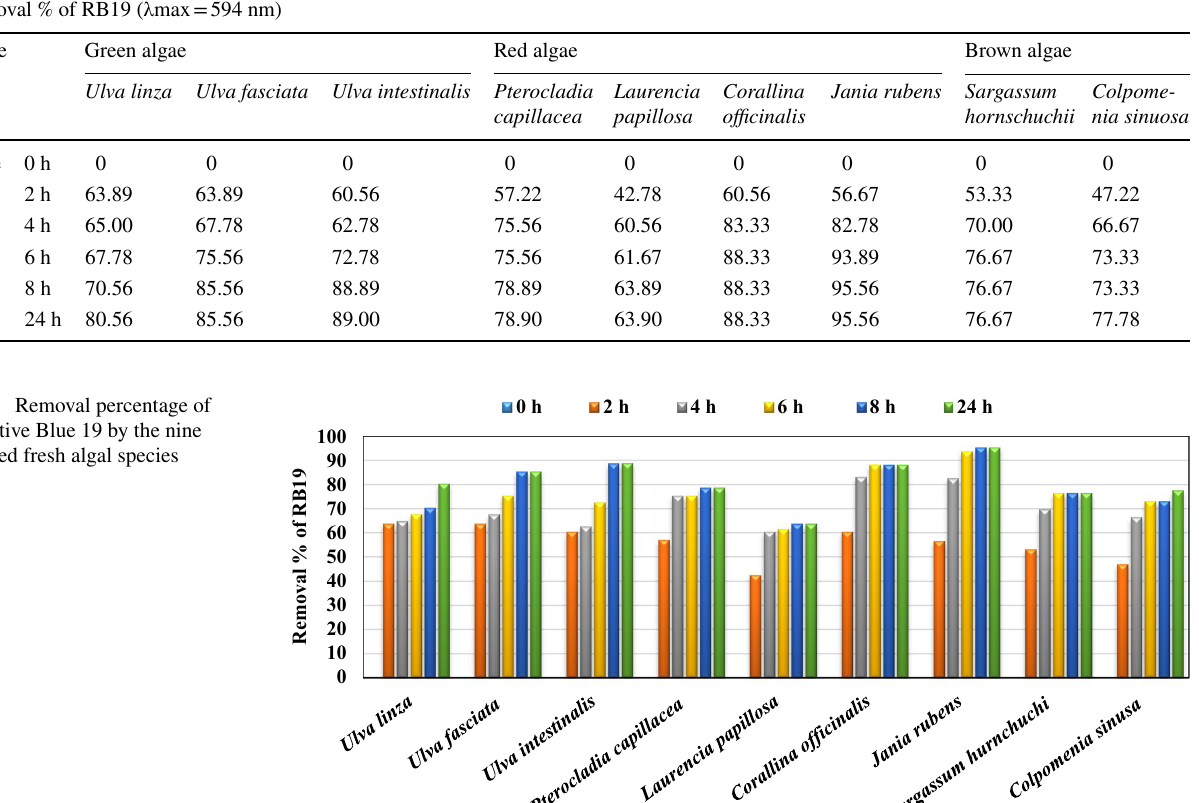
Table 1 Removal percentage of Reactive Blue 19 (RB19) by the nine studied fresh algal species Removal % of RB19 (λmax = 594 nm)